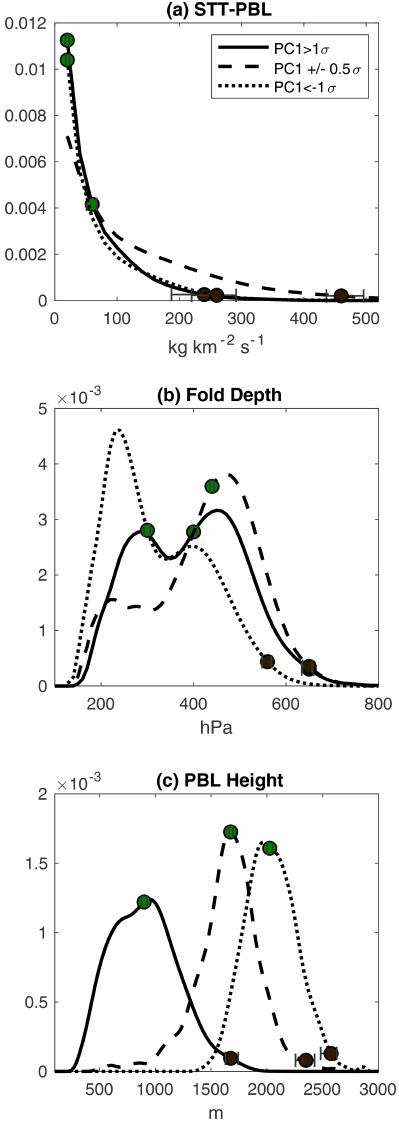
Figure 5. (a) Distribution of STT-PBL during positive (solid), neu- tral (dashed), and negative (dotted) jet phases. (b) As in (a) but for the distribution of the maximum tropopause fold pressure observed within folds passing over the western United States. (c) As in (a) but for 6h forecasts of 18:00UTC PBL height. The green dots show the bootstrapped medians of each distribution, and the black dots show the bootstrapped 99th percentile